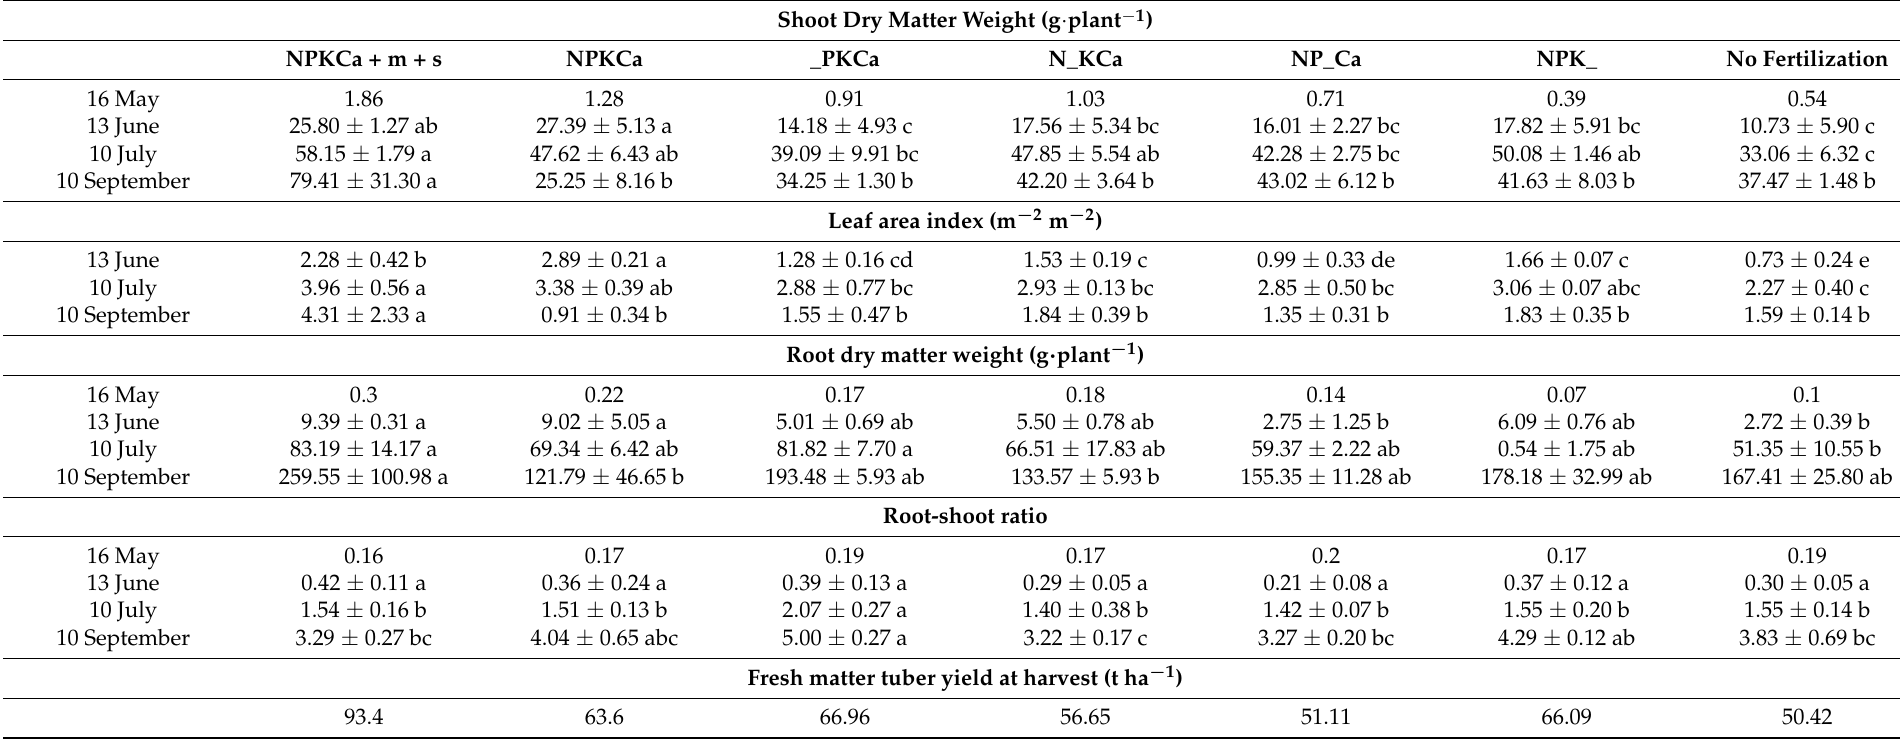
Table 3. Mean values (and standard deviation if replicates were available) of the observed shoot and root variables of sugar beet at the four sampling dates (three in case of leaf area index) and fresh matter tuber yield of the core plot at harvest in 2019 at the long-term fertilizer experiment Dikopshof, Germany. Different letters indicate significant differences (ANOVA, α =